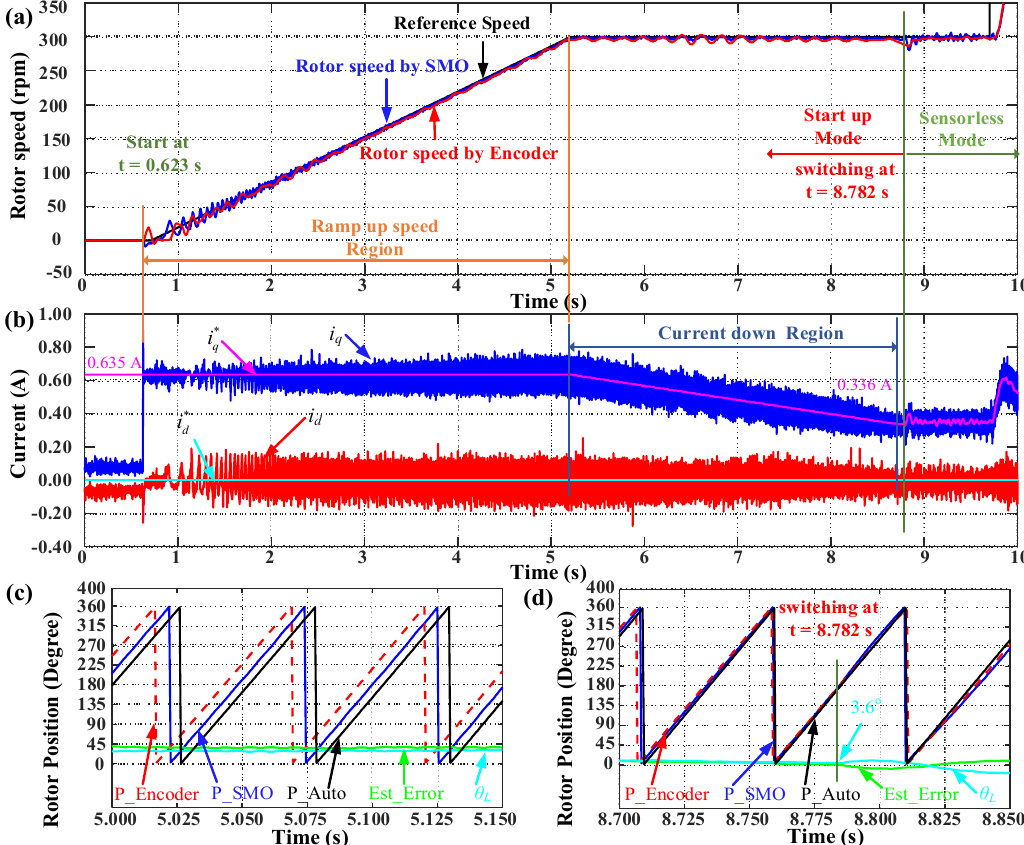
Figure 14. Experimental results in the startup mode and sensorless switching, from 0 rpm to 300 rpm, for ( a ) speed response, ( b ) current response, ( c ) rotor position response.